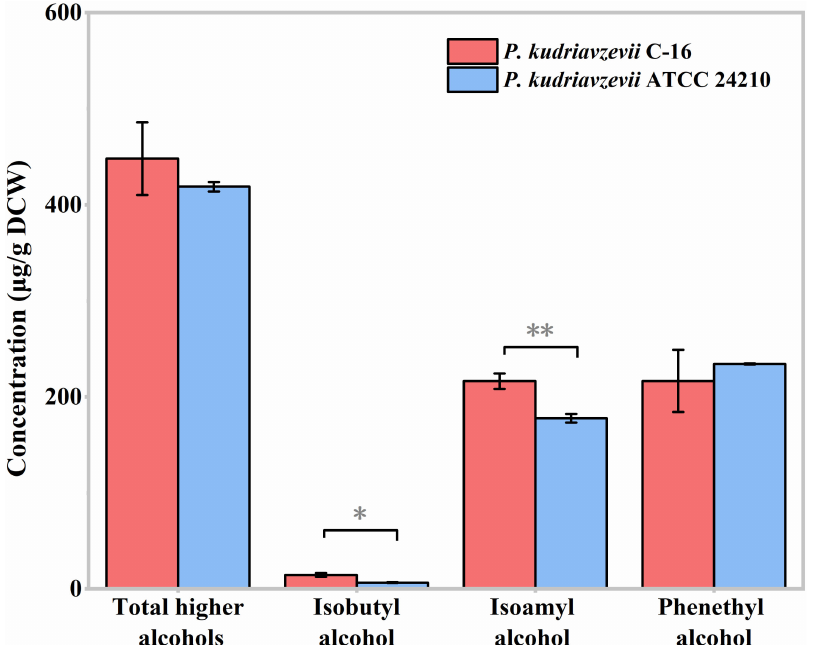
Figure 6. Higher alcohols production of P. kudriavzevii C-16 and its type strain ATCC 24210. Under 30 g/L lactic acid stress and the initial pH of the culture medium was adjusted to 3.5. “Total higher alcohols” means the sum of isobutyl alcohol, isoamyl alcohol, and phenethyl alcohol. * p < 0.05, ** p <